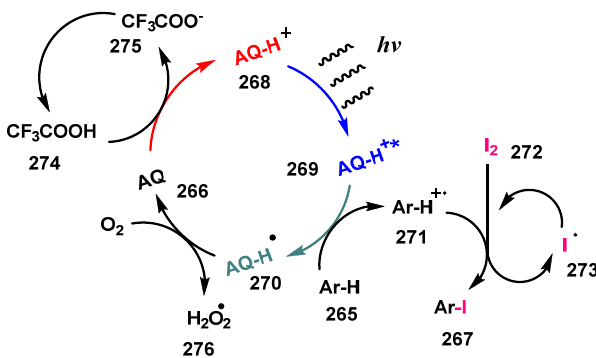
Scheme 70. Proposed mechanism of the photocatalytic oxidative iodination